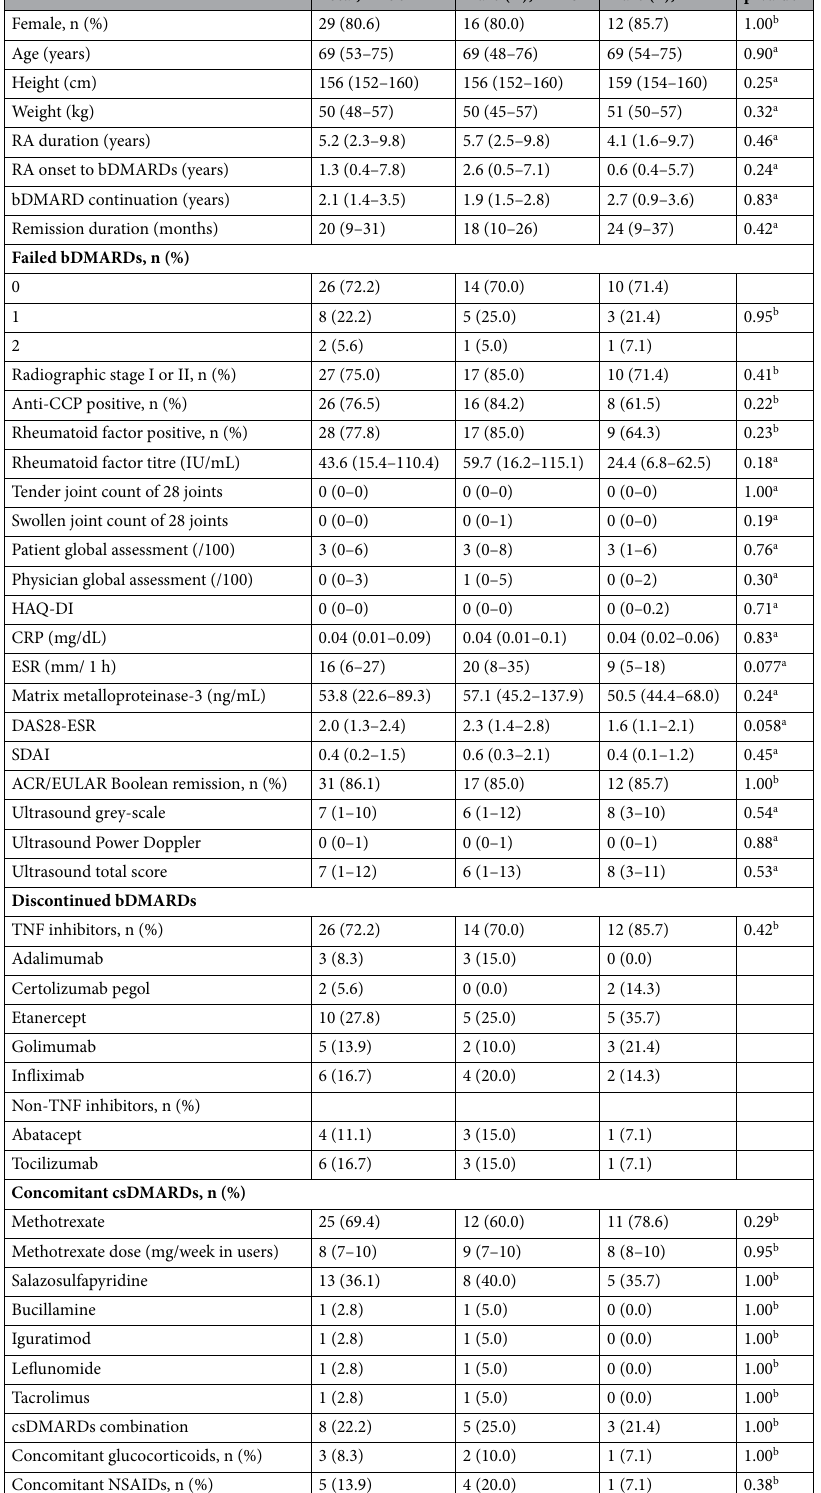
Table 1. Patient demographics and baseline clinical features. Values are presented as median (interquartile range [IQR]) unless otherwise specified. a Mann–Whitney U test. b Fisher’s exact test. RA rheumatoid arthritis, sedimentation rate, DAS28 disease activity score 28, SDAI simplified disease activity index, ACR/EULAR the American College of Rheumatology/the European League Against Rheumatism, TNF tumour necrosis factor, NSAIDs nonsteroidal anti-inflammatory